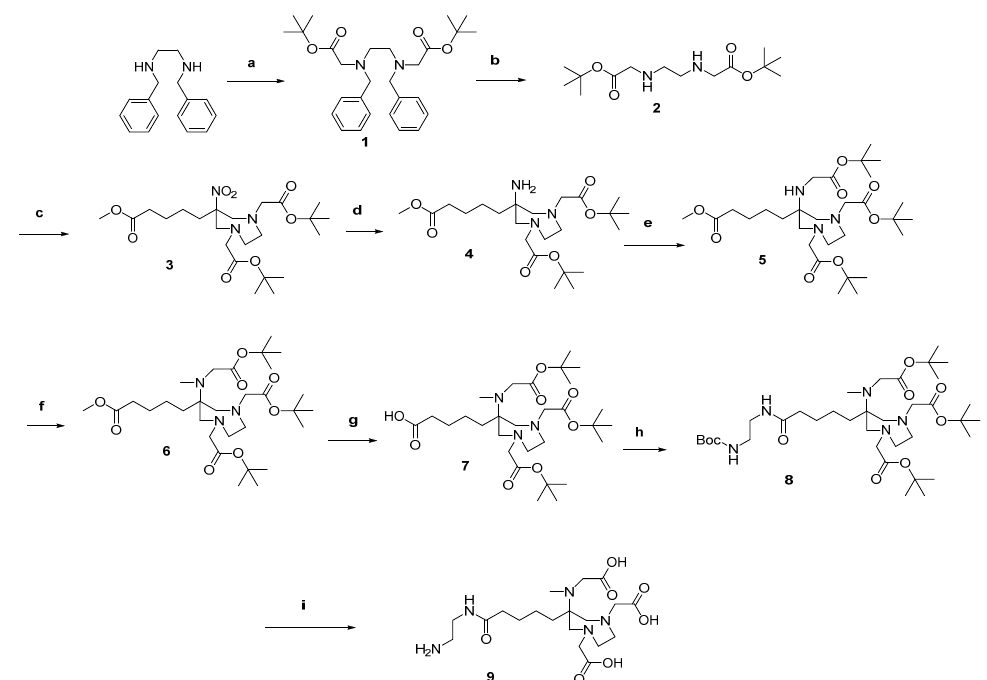
Figure 3. Synthesis of DATA 5m : (a) tert-butyl bromoacetate, Na 2 CO 3 , MeCN, 96%; (b) Pd/C, EtOH, formic acid, H 2 , 98%; (c) paraformaldehyde, 2-nitrocyclohexanone, MeOH, 77%; (d) Raney ® -Nickel, EtOH, H 2 , 72%; (e) tert -butyl bromoacetate, DIPEA, MeCN, 62%; (f) Formalin (37%), AcOH, NaBH 4 , ACN, 74%; (g) LiOH, dioxane/H 2 O, 84%; (h) tertbutyl(2aminoethyl)carbamate, HATU, DIPEA, ACN, 94%; (i) TFA/DCM, 1:1.